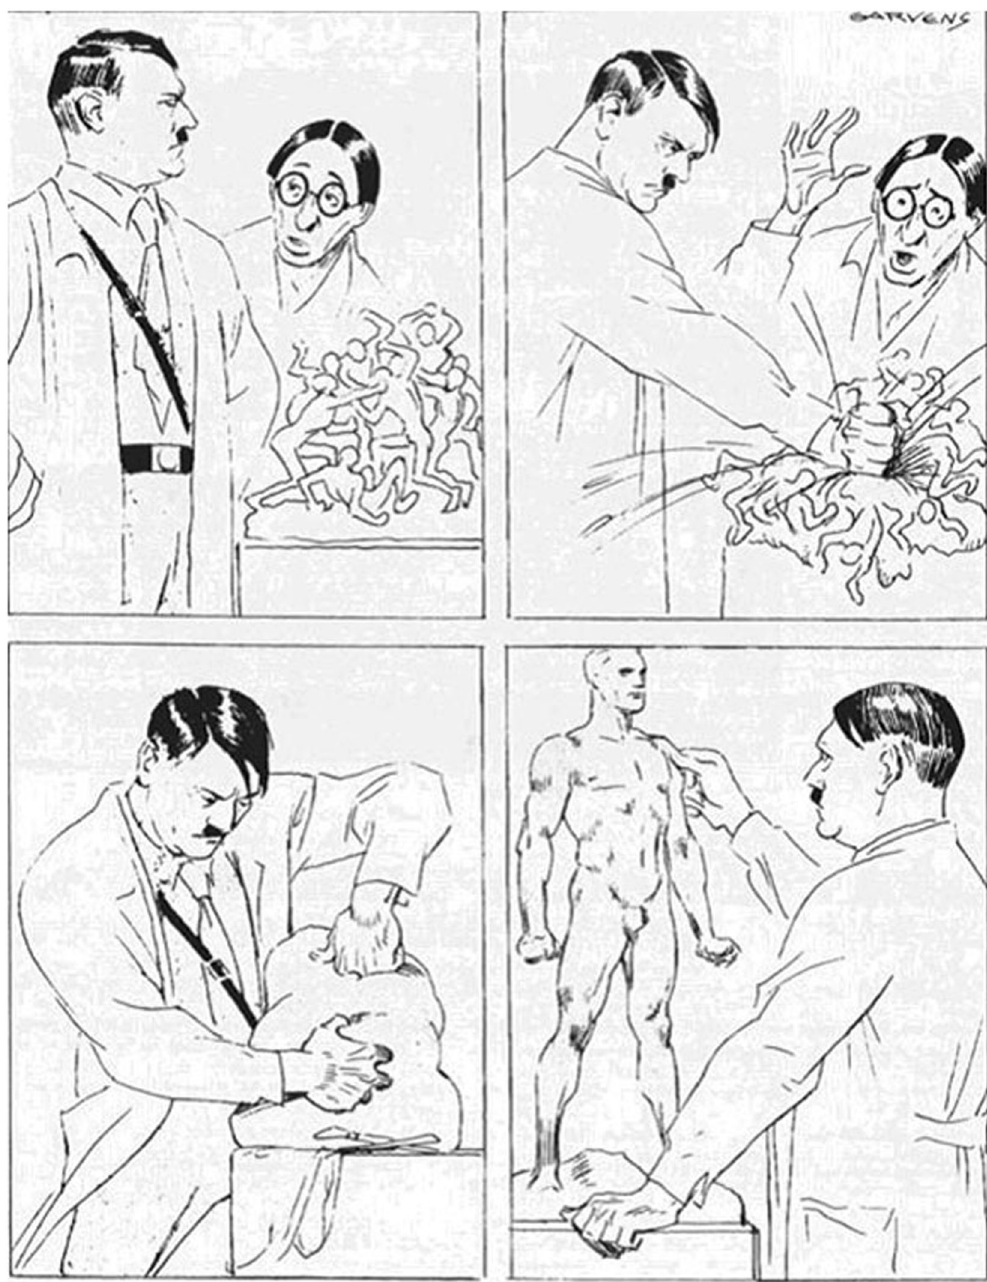
Fig. 2 O. Garvens, “ The Sculptor of Germany ” , 1933. A political cartoon which shows Hitler as the sculptor of a uni fi ed, singular